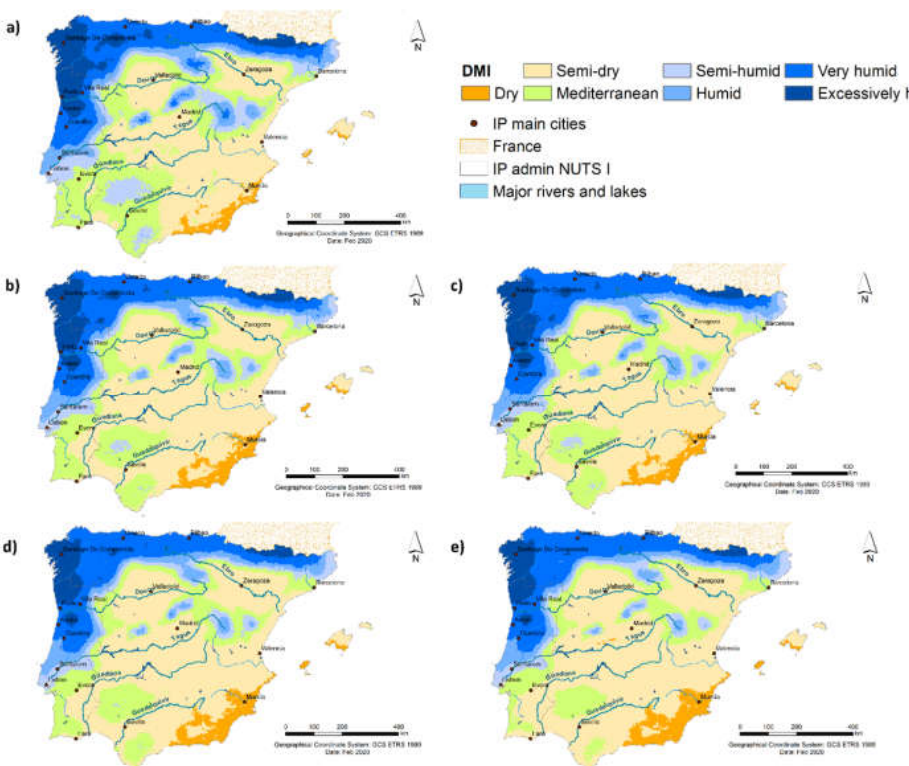
Figure 4. The De Martonne Aridity Index (DMI) spatial distribution for the Iberian Peninsula for the period ( a ) 1961–1990, ( b , c ) 2011–2040, and ( d , e ) 2041–2070, under RCP4.5 ( left ) and RCP8.5 ( right ). Table 3. Percentage of the territory for each climate of the De Martonne Aridity Index (DMI), the Pinna Combinative Index (PCI), and the Erinç Aridity Index (EAI) for 1961–1990 and 2011–2040 and 2041–2070 under RCP4.5 and RCP8.5 (note that = 2041−2070−1961−1990 in %).